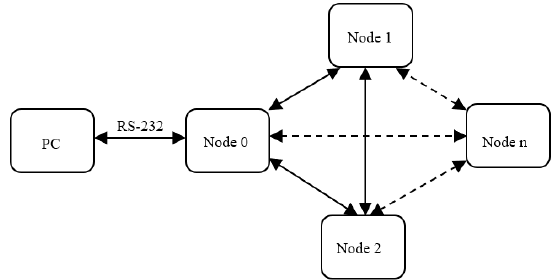
Figure 2. Received Signal Strength Indicator (RSSI) measurement system architecture. Although